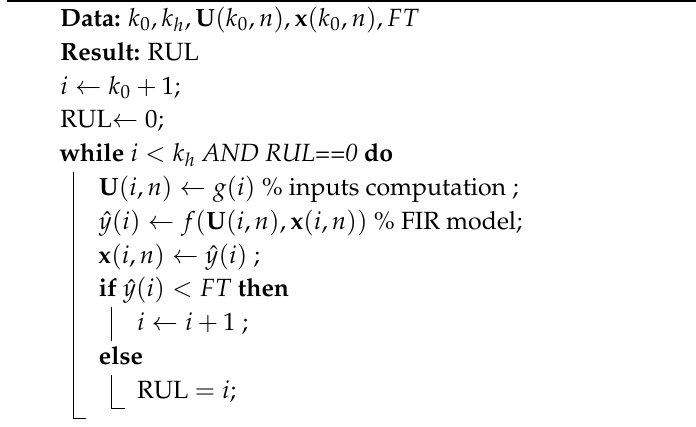
Algorithm 1: Remaining useful life (RUL) forecast with a fuzzy-inductive-reasoning (FIR)